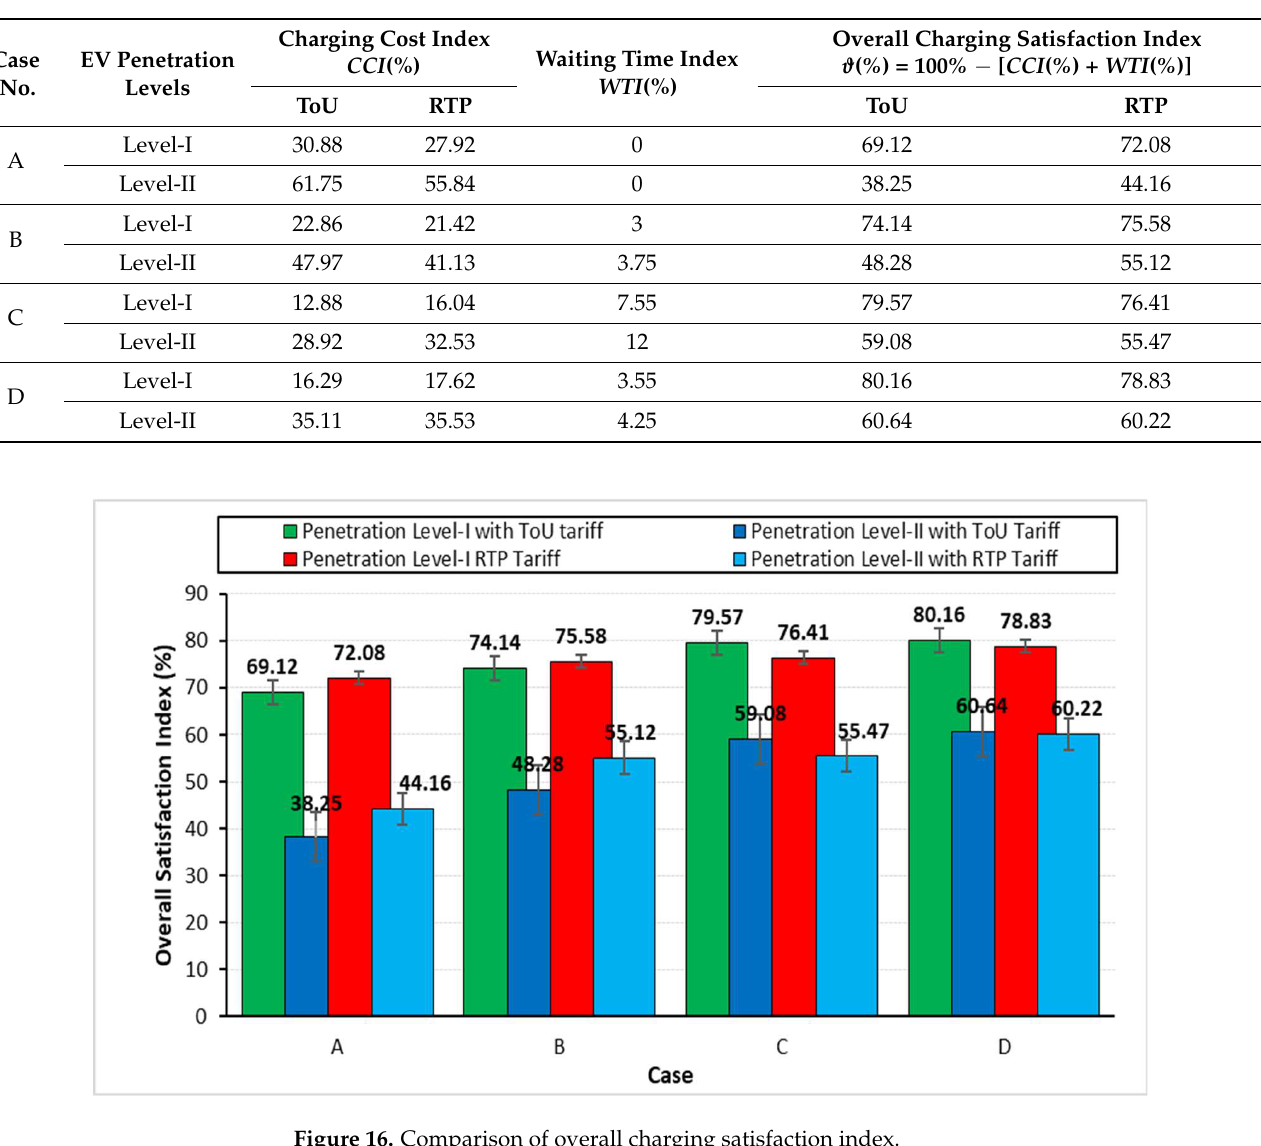
Table 6. Overall charging satisfaction index for each case.